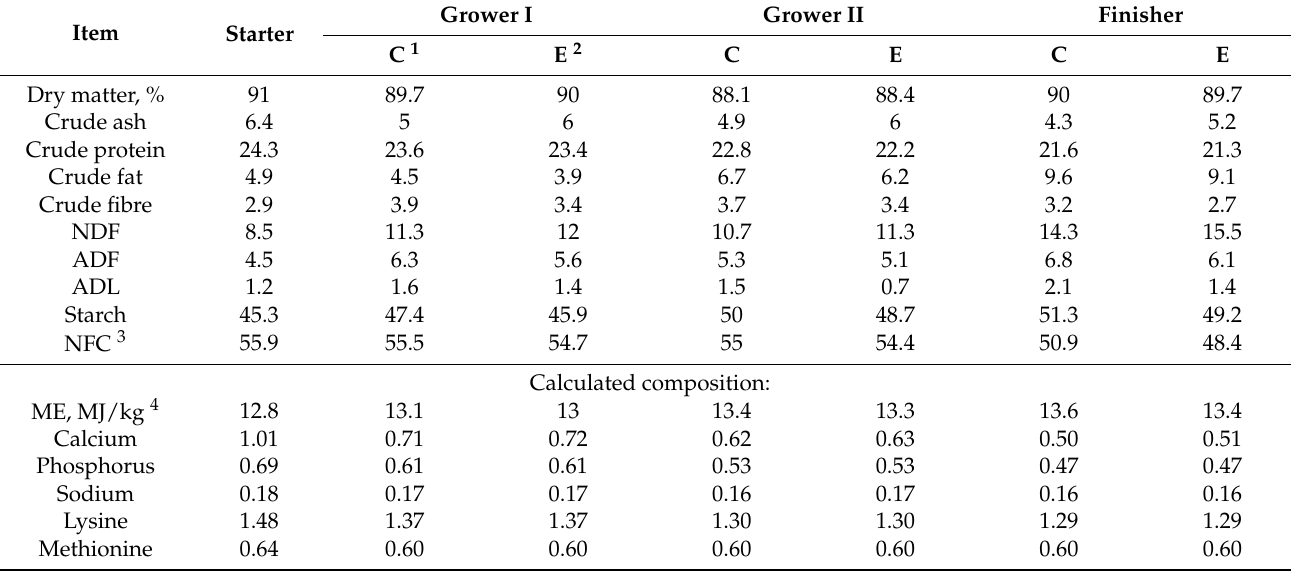
Table 1. Chemical composition of compound feeds (% of dry